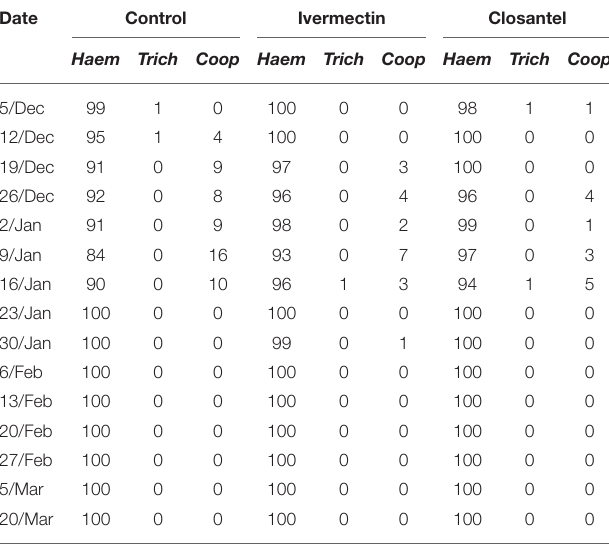
TABLE 5 | Percentage of infective larvae of Haemonchus spp. ( Haem ) , Trichostrongylus spp. ( Trich ) e Cooperia spp. ( Coop ) in fecal cultures from control, ivermectin and closantel groups.